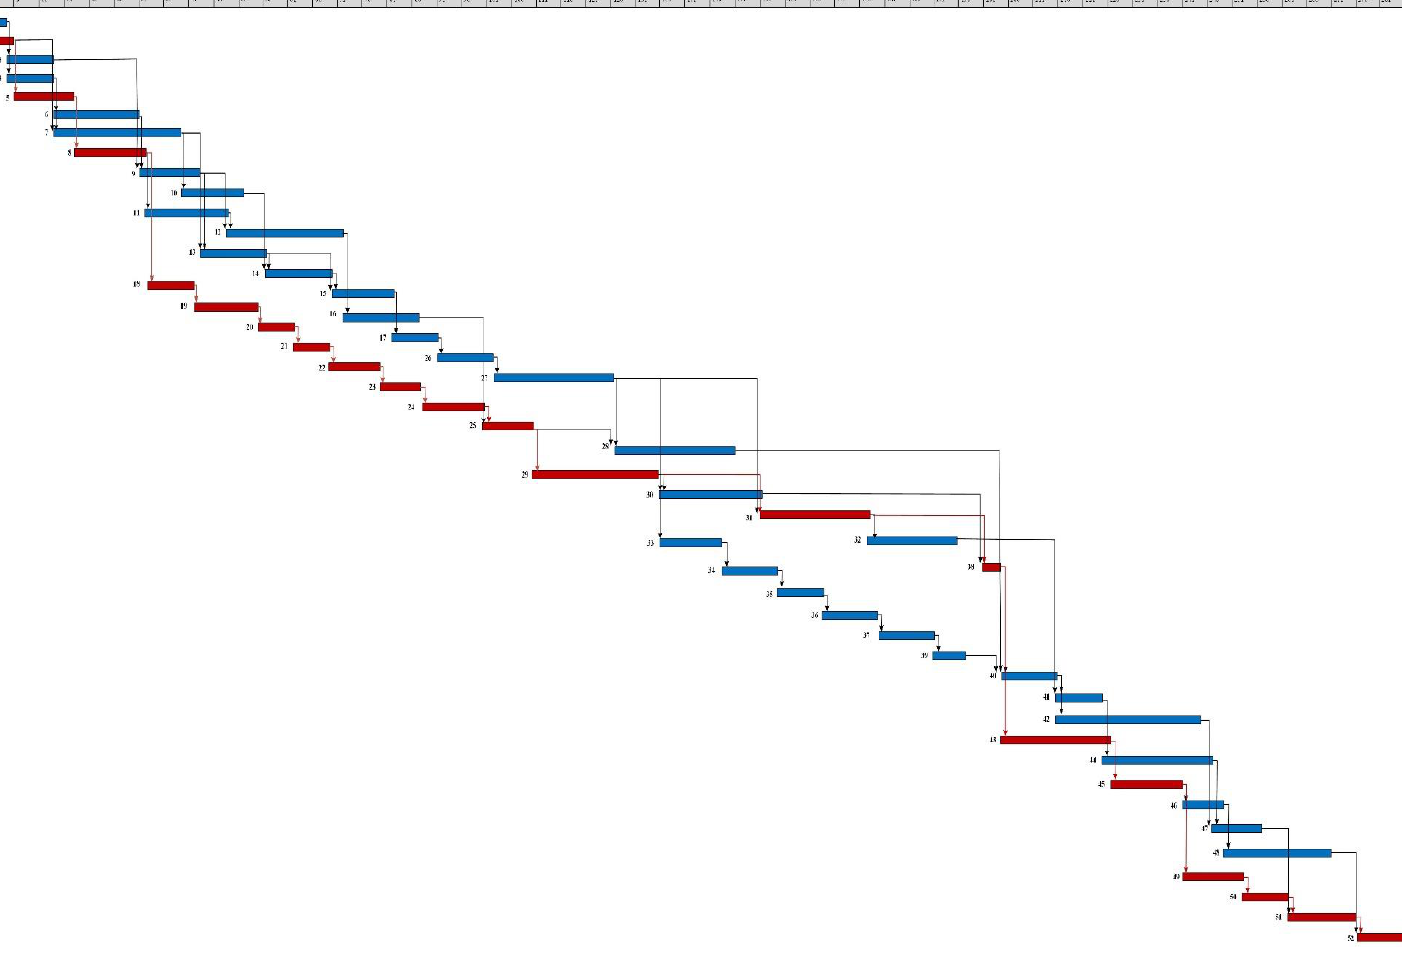
Figure 15. Optimal schedule yields a 286 -day duration — considering precedence relationships only (red blocks refer to critical